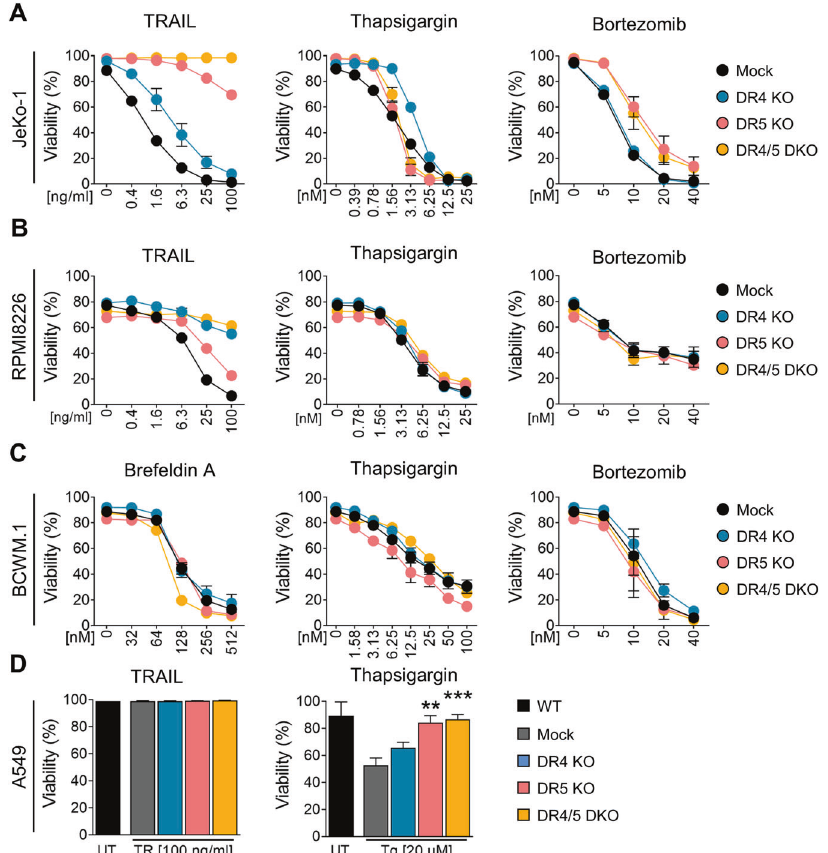
Fig. 3 Consequences of DR4/5 gene ablation for TRAIL and ER-stress cell death responses. A JeKo-1 Mock, DR4 KO (pool), DR5 KO (clonal population) and DR4/5 DKO (clonal population) cells were incubated with TRAIL or Thapsigargin for 48 hours and with Bortezomib for 24 hours. Cells were then collected and viability was measured via FACS using DiOC6 and ToPro-3 staining. Analyses were performed selecting cells for DiOC6 + and ToPro-3-. Results are shown as Mean ± SEM ( N = 3). B Same as A but with RPMI8226 cells but for 24 hours. RPMI8226 DR4 KO and DR4/5 DKO are pool of KO cells, DR5 KO is a clonal population. Results are shown as Mean ± SEM ( N = 3). C Same as A but with BCWM.1 cells and with Brefeldin A instead of TRAIL treatment. BCWM.1 DR4 and DR5 KOs are clonal populations, DR4/5 DKO is a pool of KO cells. Results are shown as Mean ± SEM ( N = 3). D A549 WT, Mock, DR4 KO (pool), DR5 KO (clonal population) and DR4/5 DKO (clonal population) cells were incubated with normal media or media containing 100 ng/ml TRAIL (TR) or 20 µM Thapsigargin (Tg) for 48 hours. Cells were then collected and viability was measured via FACS using Propidium Iodide (PI) staining. Dead cells were selected as PI + cells. Results are shown as Mean ± SEM (TRAIL N = 3 and Thapsigargin N ≥ 4). Asterisks denote signi fi cant differences with Thapsigargin-treated mock- transfected